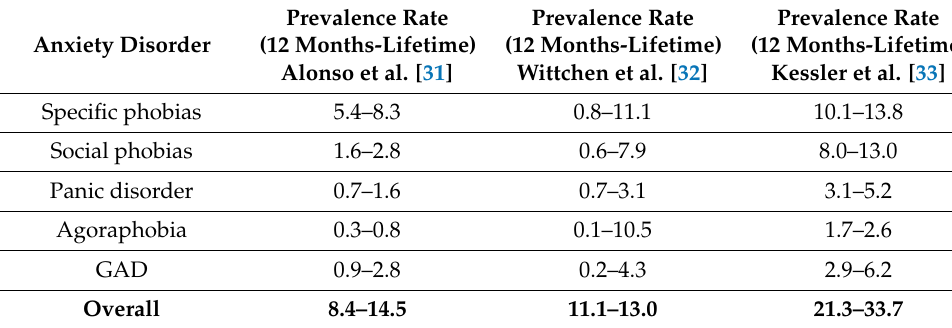
Table 2. Prevalence rates of different anxiety